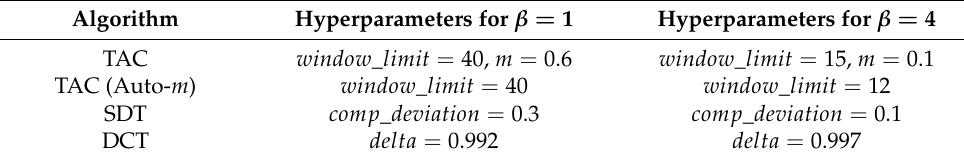
Table 5. Optimal hyperparameters: Dataset